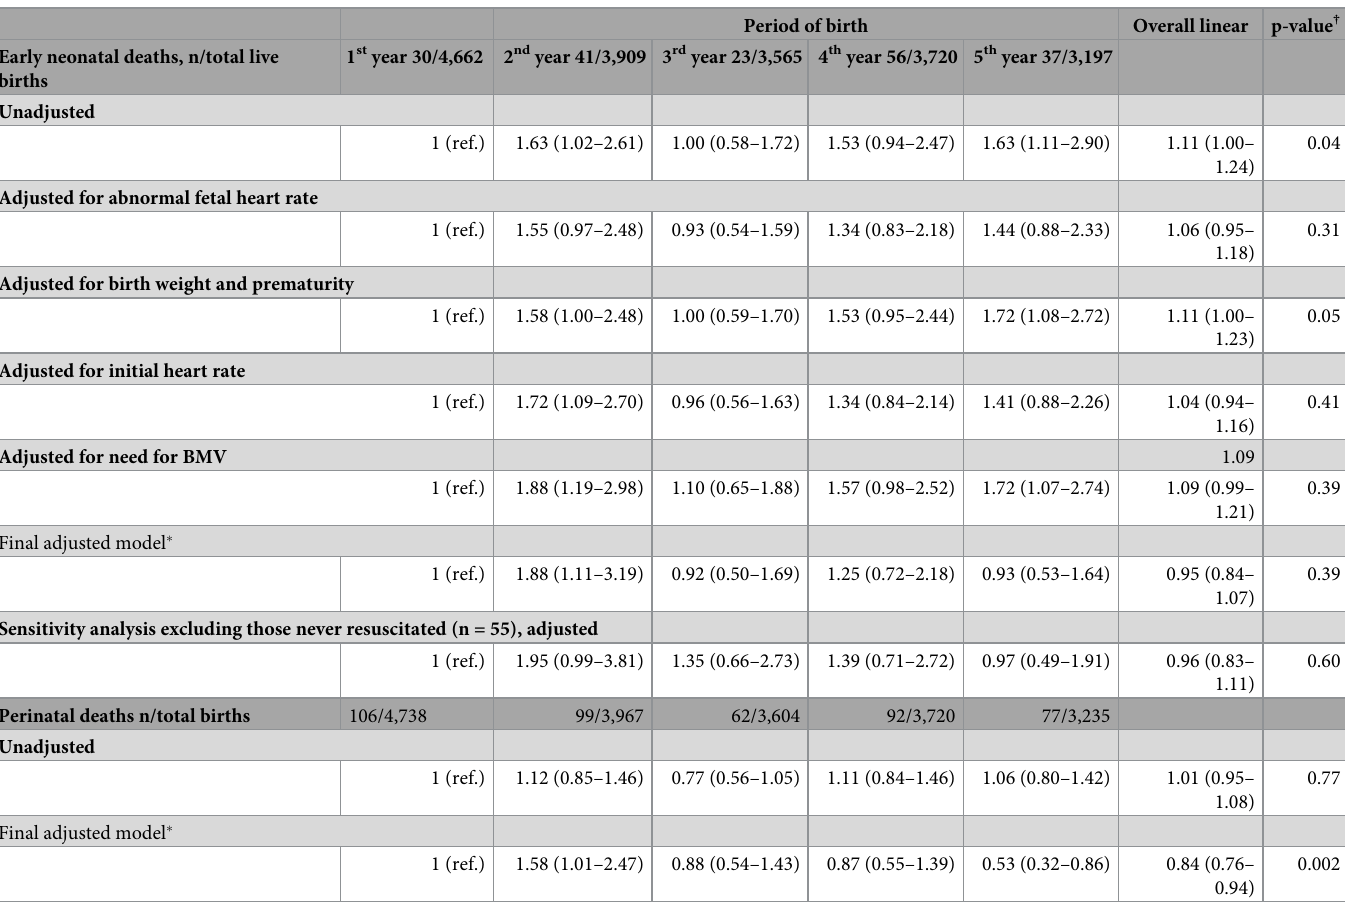
Table 3. Relative risk for early neonatal death and perinatal death at Haydom